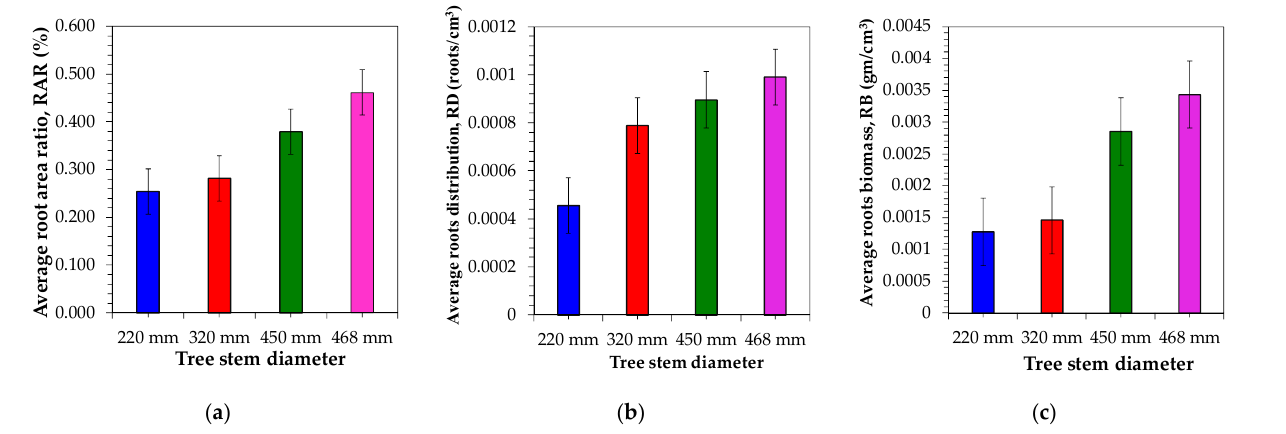
Figure 12. Variation of roots indices with tree stem diameter ( a ) RAR ( b ) RD ( c ) RB.